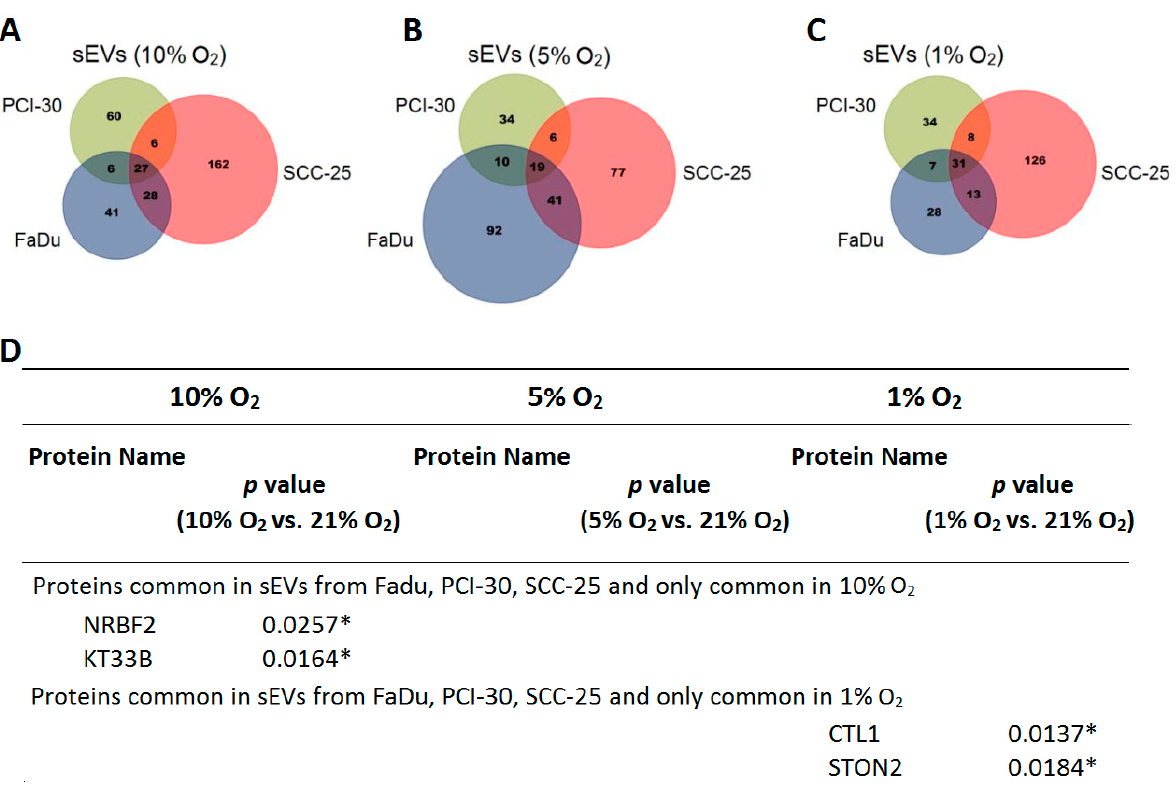
Figure 3. Venn diagrams show numbers of proteins detected in Head and Neck Squamous Cell Carcinoma (HNSCC)- derived small extracellular vesicles (sEVs) obtained from supernatants of the cells exposed to ( A ) 10% O 2 ( B ), 5% O 2, and ( C ) 1% O 2 . ( D ) Protein profile in indicated degrees of hypoxia. Kruskal-Wallis test was used to compare the difference in intensities between oxygenation groups of their expression vs. normoxia. To isolate differences between groups Benjamini- Krieger-Yekutieli two-stage linear step-up procedure was performed. Differences were considered significant at * p < 0.05. Full table with detected proteins shared by hypoxic HNSCC-derived sEVs is presented in Table S2.